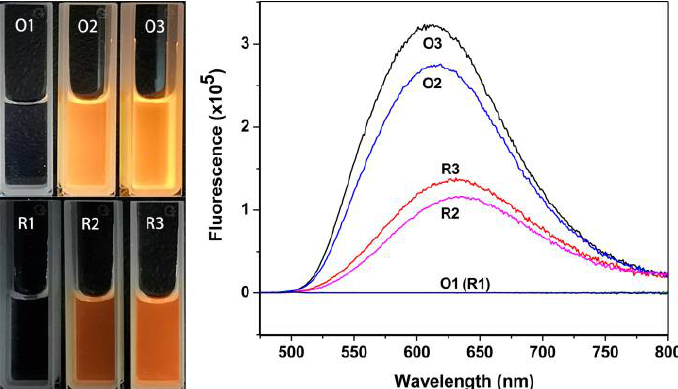
Figure 2. Photograph ( left panel ) and fluorescence emission spectra ( right panel ) of the AuNCs synthesized using GSH (denoted R) and GSSG (denoted O) as reducing and capping agents. Conditions: 1, reacting for 2 min at room temperature; 2, condition 1 first, then continuous heating at 80 °C for 24 h; 3, condition 1 first, then intermittent heating at 80 °C and at ambient temperature, alternately, each for 4 h, for a total time of 24 h. The photograph was taken under UV light at 365 nm. The synthesis conditions for R2 were adopted from the literature [35].